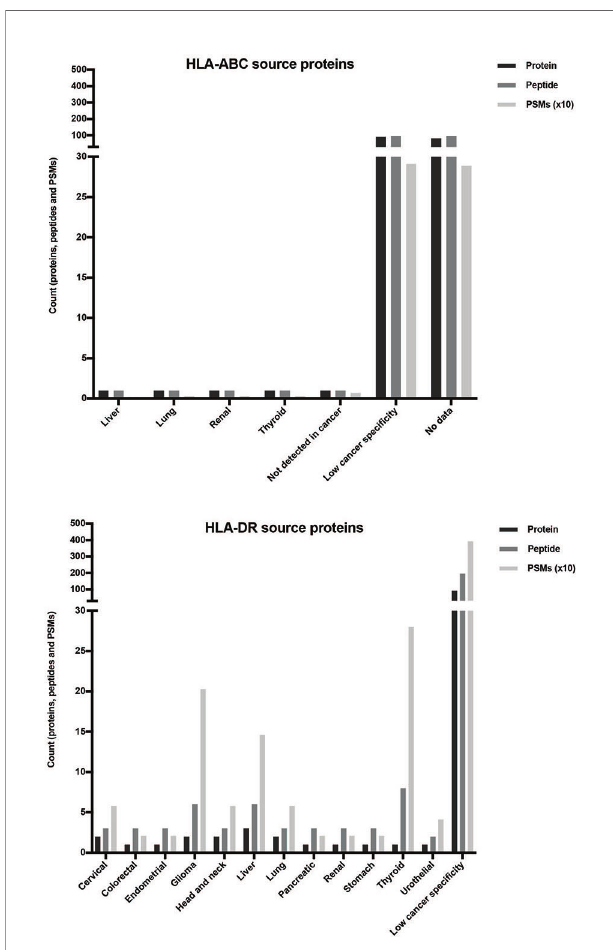
FIGURE 6 | Distribution of the selected proteins obtained from the XABCLLCL HLA repertoire based on their expression in cancer. After comparing the source proteins with those found in the literature, the expression in cancer of 178 (HLA-ABC-associated) and 102 (HLA-DR- associated) proteins was checked by the Human Protein Atlas. Counts of proteins, peptides, and PSM obtained are represented. The highest count in all the measures corresponded to proteins with low cancer speci fi city, i.e., proteins enriched in many cancer tissues. Two proteins from HLA-ABC- derived peptides showed speci fi city in certain cancers. Regarding the HLA- DR results, peptides with high PSM values corresponded to speci fi c proteins from thyroid cancer (280 PSM and 8 peptides contained in 1 nested set and derived from 1 protein), glioma (203 PSM and 6 peptides derived from 2 proteins), and liver cancer (146 PSM and 6 peptides derived from 3